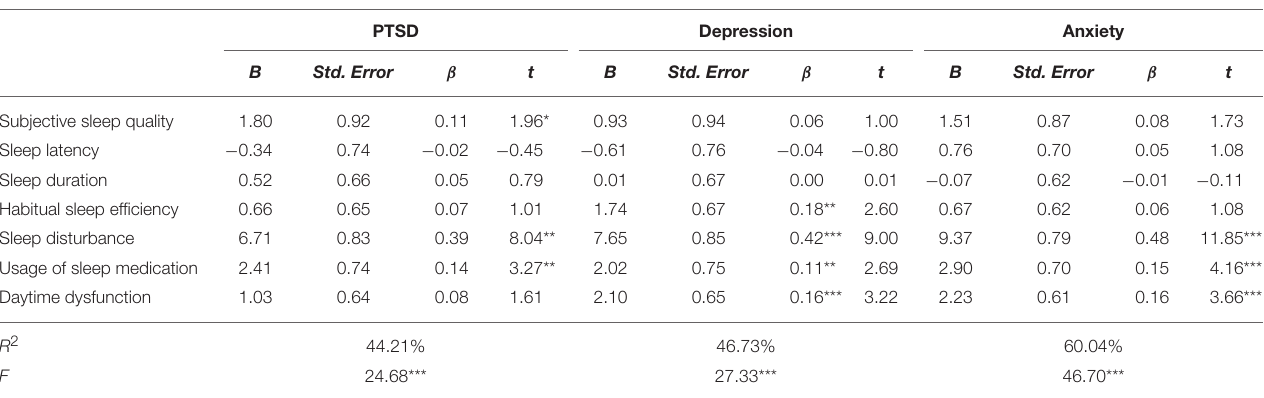
TABLE 6 | Regression analysis for PTSD, depression, and anxiety. PTSD